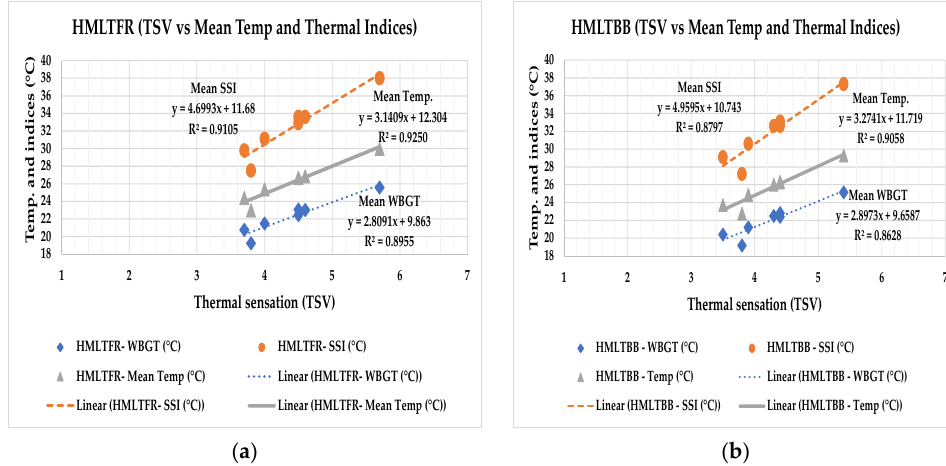
Figure 8. Correlations between the mean temperatures, thermal indices, and TSV in ( a ) HMLTLL and ( b ) HMLTBB.